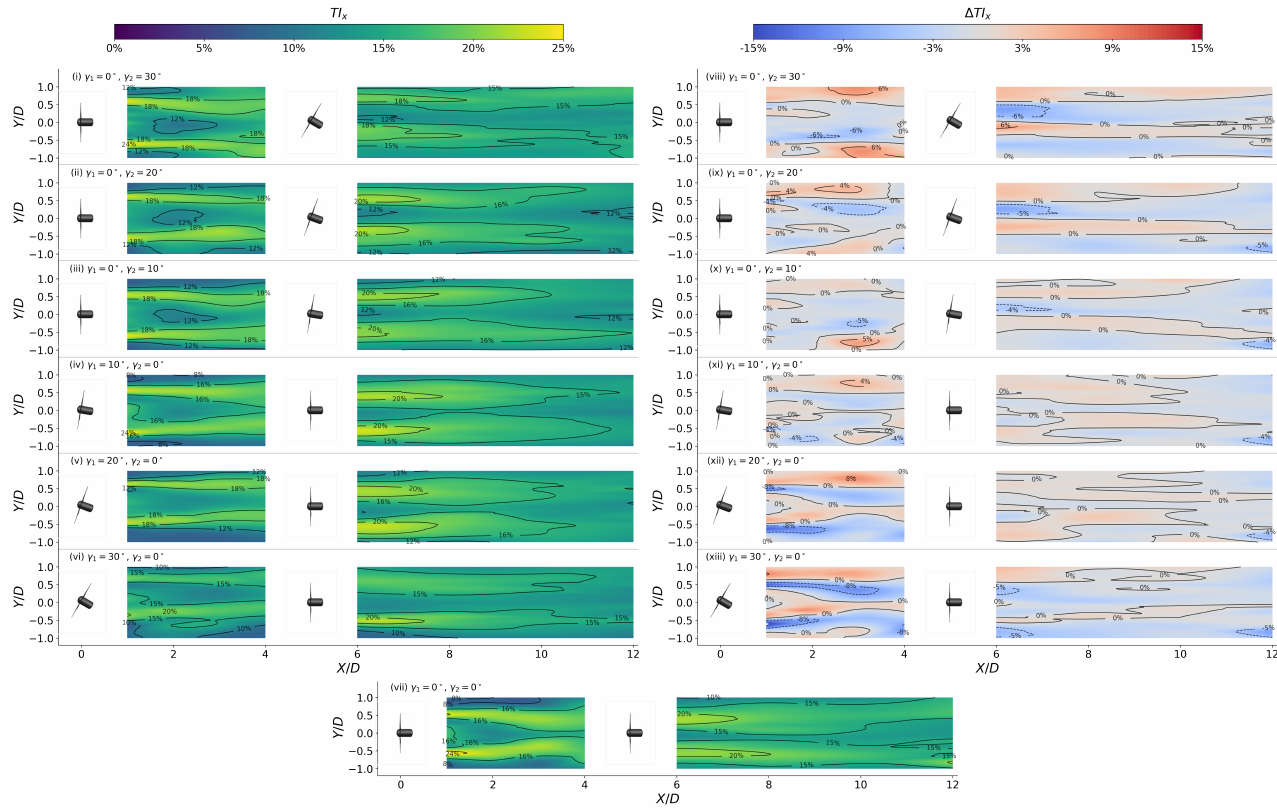
Figure 10. Distribution of streamwise turbulence intensity in the non-yawed case and rela- tive differences between yawed and non-yawed cases for Scenario 2: (i) TI x 0 ◦ ,10 ◦ , (ii) TI x 0 ◦ ,20 ◦ , (iii) TI x 0 ◦ ,30 ◦ , (iv) TI x 10 ◦ ,0 ◦ , (v) TI x 20 ◦ ,0 ◦ , (vi) TI x 30 ◦ ,0 ◦ , (vii) TI x 0 ◦ ,0 ◦ , (viii) ∆ TI x = TI x 0 ◦ ,10 ◦ − TI x 0 ◦ ,0 ◦ , (ix) ∆ TI x = TI x 0 ◦ ,20 ◦ − TI x 0 ◦ ,0 ◦ , (x) ∆ TI x = TI x 0 ◦ ,30 ◦ − TI x 0 ◦ ,0 ◦ . (xi) ∆ TI x = TI x 10 ◦ ,0 ◦ − TI x 0 ◦ ,0 ◦ , (xii) ∆ TI x = TI x 20 ◦ ,0 ◦ − TI x 0 ◦ ,0 ◦ , and (xiii) ∆ TI x = TI x 30 ◦ ,0 ◦ − TI x 0 ◦ ,0 ◦ . The quoted distances are downstream of the upstream turbine in all